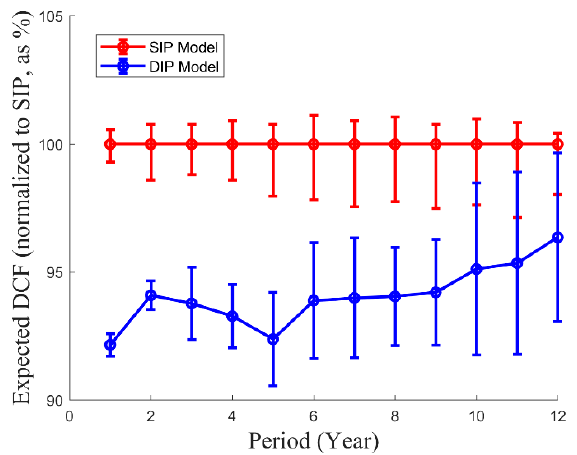
Figure 9. Expected discounted cash flow (DCF) from the DIP model compared to that of the SIP model as a reference case (100%). The error bars represent the P5 and P95 values obtained on the set of simulated block models; the continuous lines represent the average (expected) values.